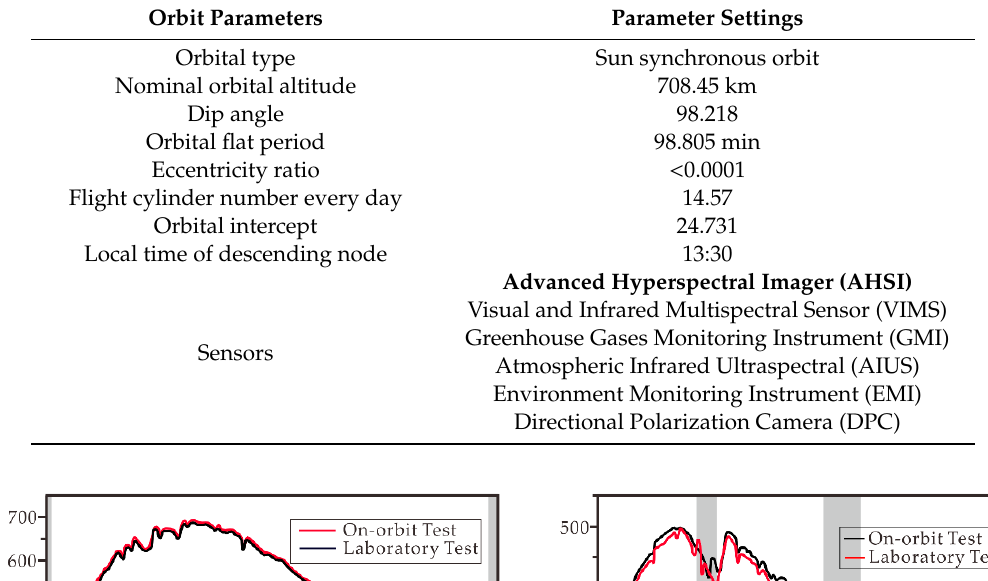
Table 1. Gaofen-5 (GF-5) satellite specification and major orbit parameters.